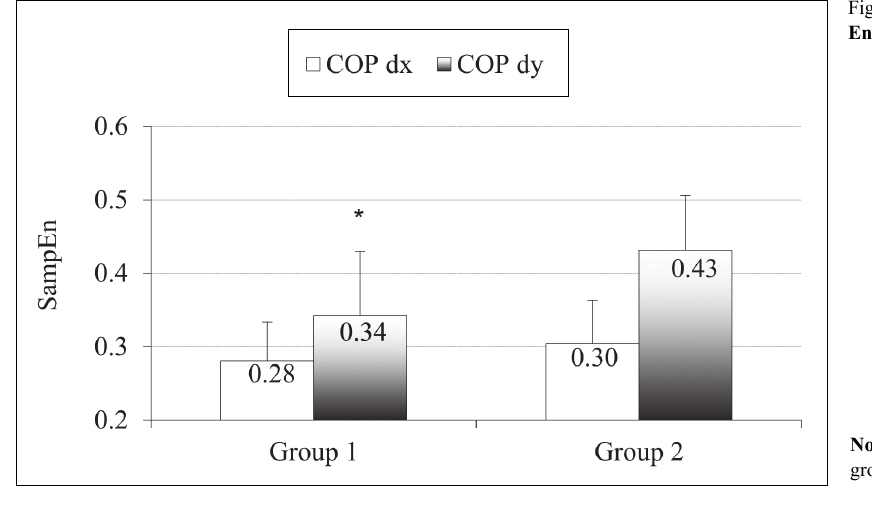
Figure 3. Mean values of Power Spectral Density dependence on Spectral Slope